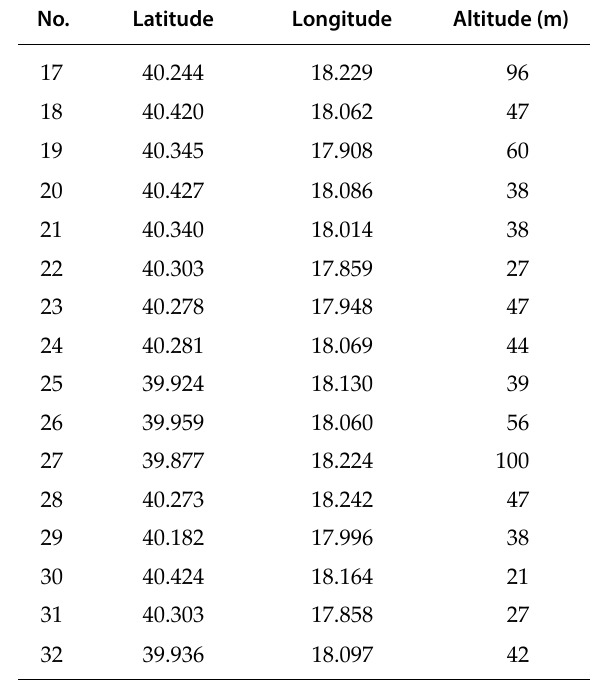
Table S.1. Latitude, longitude e altitude of X. fastidiosa records used in Maxent model. No. Latitude Longitude Altitude